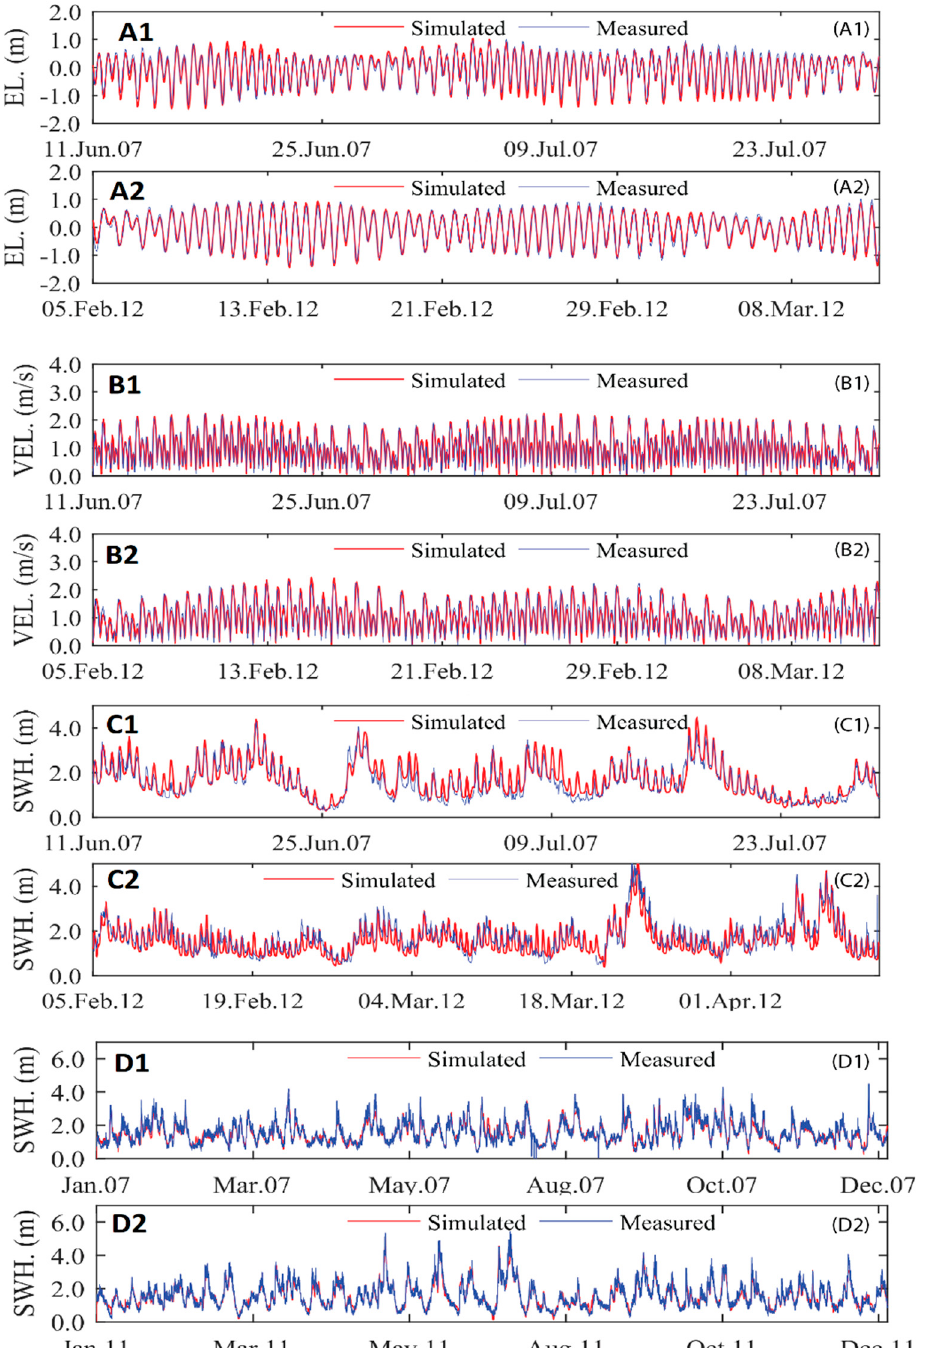
Figure 7. Comparisons between the measured and field data obtained during calibration and validation. For SCHISM, plots for water level and depth-averaged velocity at ORBCL are shown in ( A1 , A2 ) and ( B1 , B2 ), respectively. For WWMIII, the SWH at the offshore buoy location is shown in ( D1 , D2 ). The SWH for the coupling model at ORBCL is shown in ( C1 , C2 ).